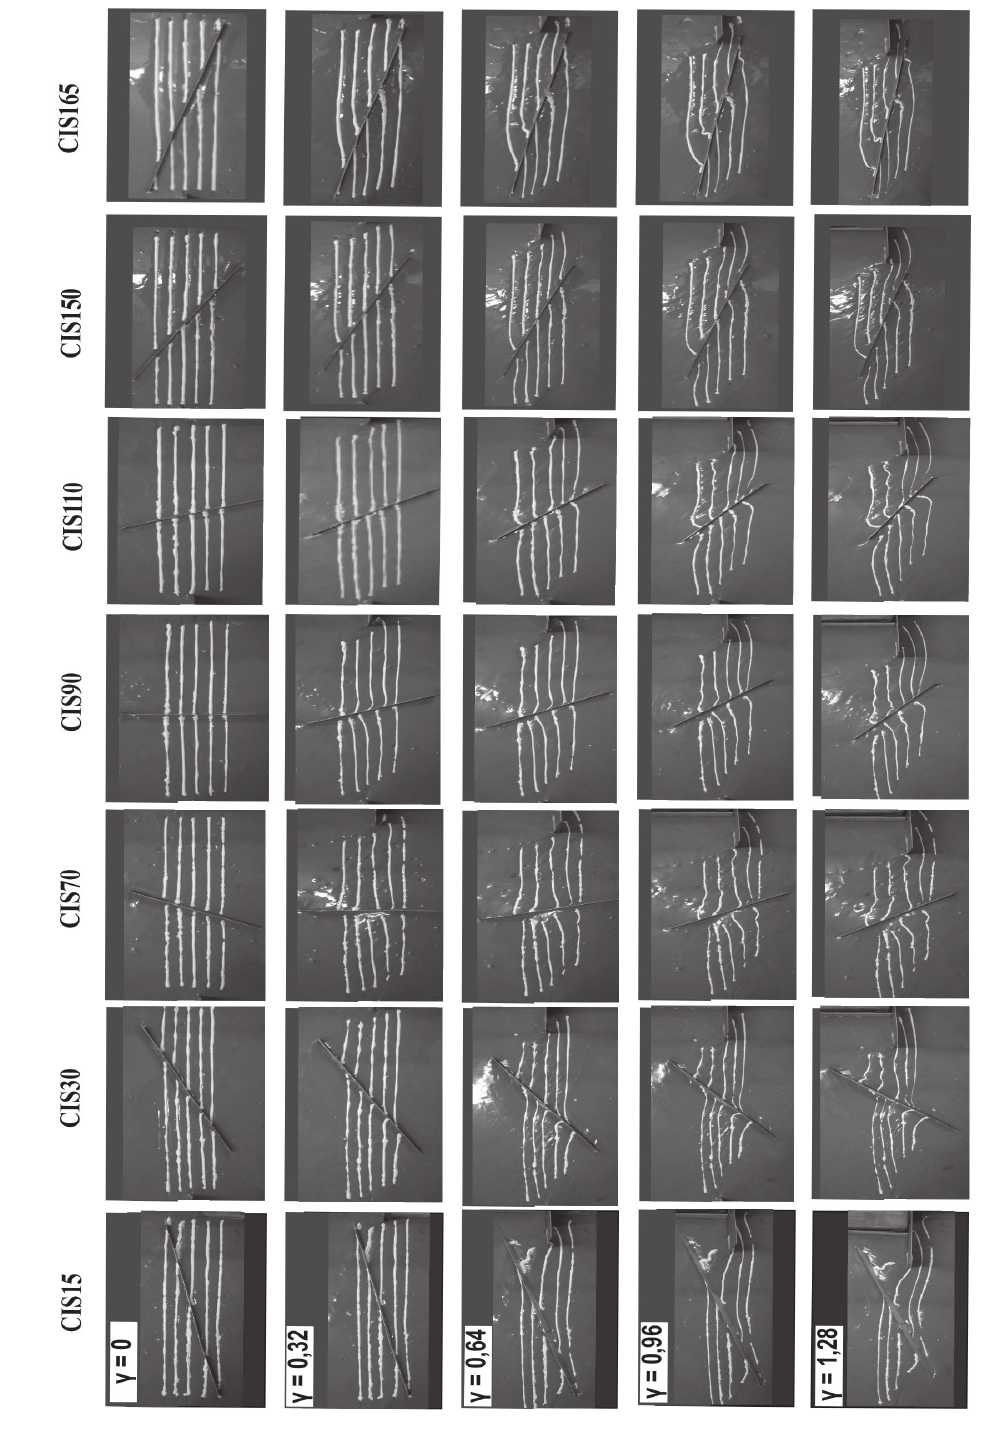
Figure 4 - Photographs of the progressive deformation of the seven analog experiments CIS15, CIS30, CIS70, CIS90, CIS110, CIS150 and CIS165. Each experiment is shown in intervals of γ = 0.32, which correspond to 2-cm intervals of linear dislocation. The height of the photographs corresponds to 12